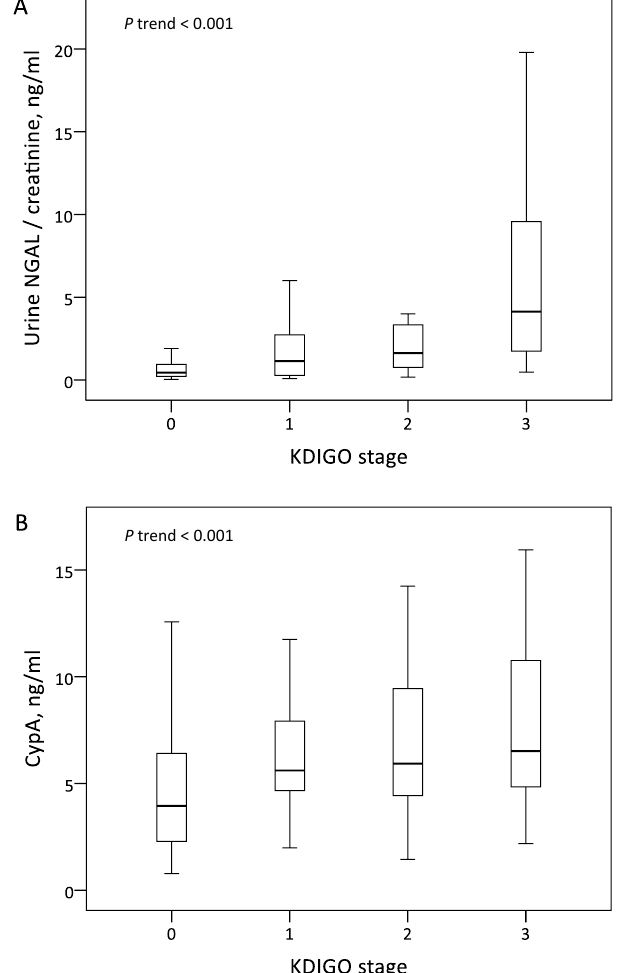
Figure 1. Levels of urine NGAL normalized by urine creatinine ( A ) and serum CypA ( B ) across KDIGO stages. Abbreviations: CypA, cyclophilin A; NGAL, neutrophil gelatinase-associated lipocalin; KDIGO, Kidney Disease Improving Global Outcomes.